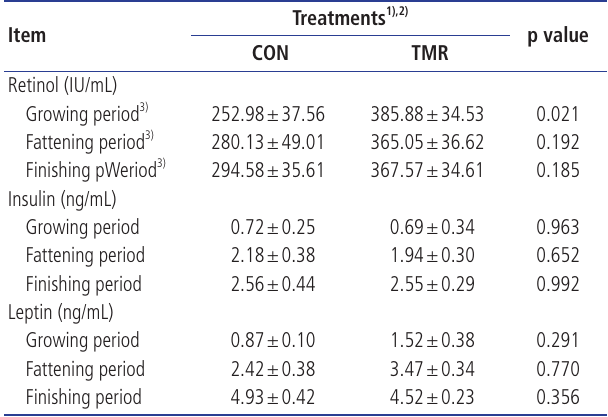
Table 5. Concentration of retinol, insulin and leptin of plasma in Hanwoo steers Item